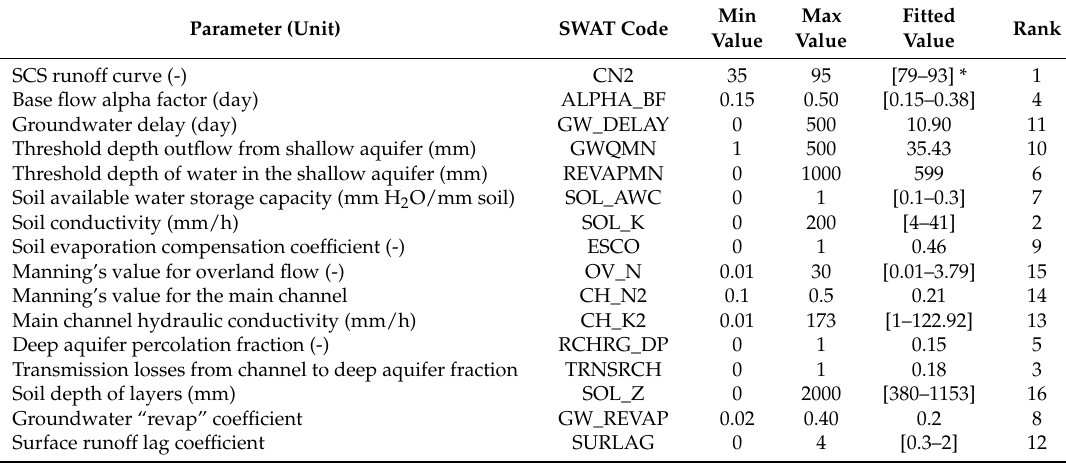
Table 1. Parameters sensitivity of discharge simulations in SWAT.